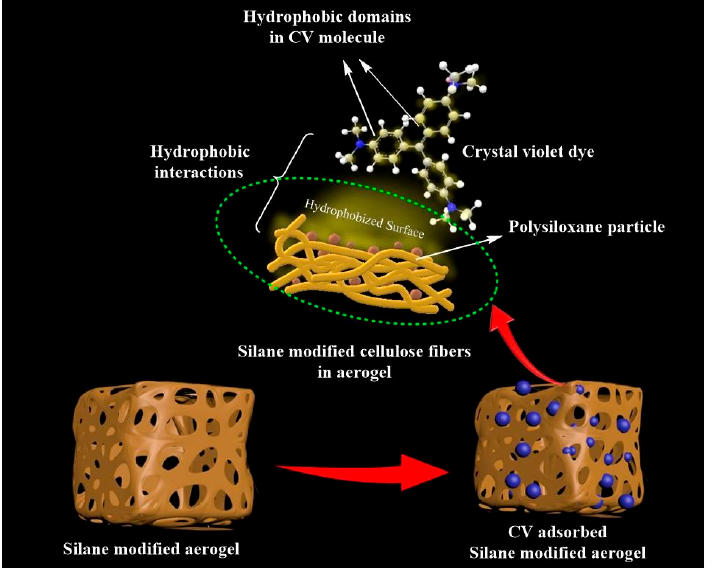
Figure 8. Proposed mechanism of crystal violet removal by silane-modified CNF aerogel.